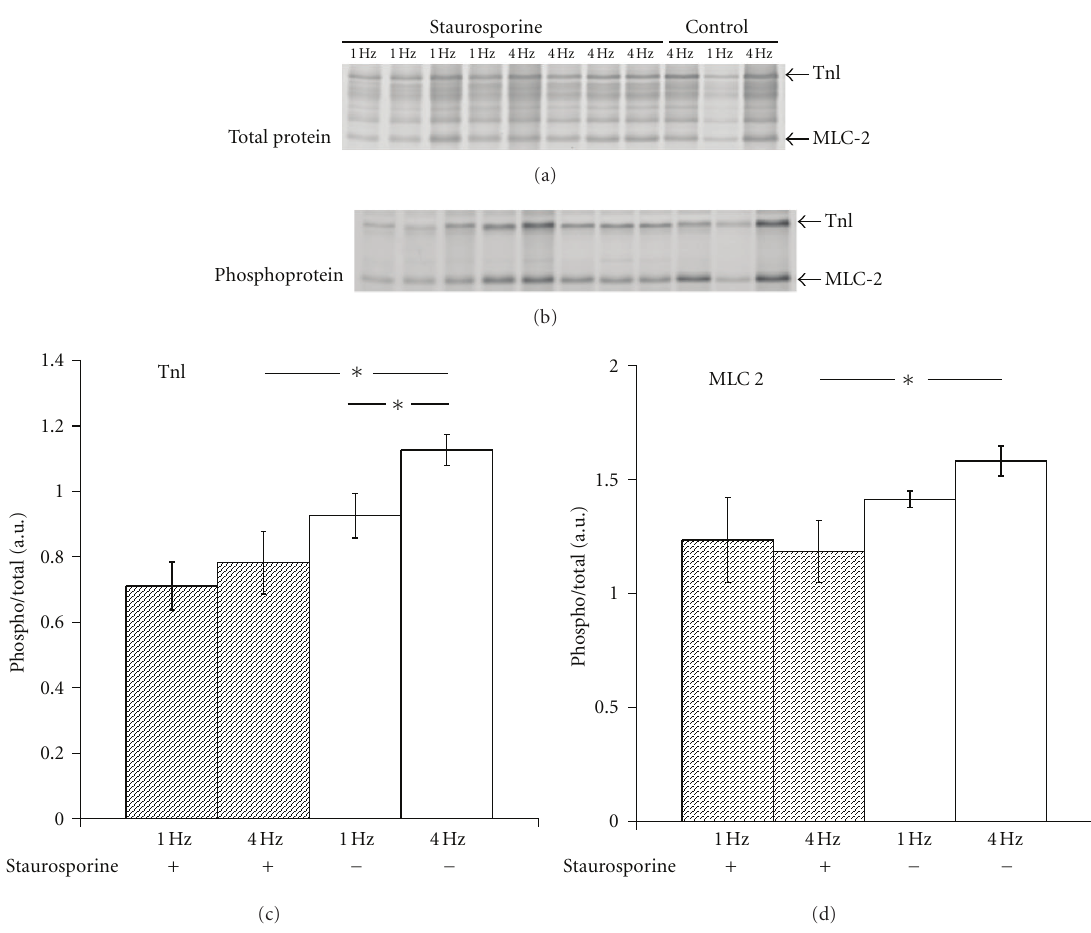
Figure 5: Analysis of TnI and MLC-2 phosphorylation status in muscles stimulated to twitch at 1 or 4Hz, with and without staurosporine. Panel (a) shows a representative SDS gel stained for total protein using the Sypro Ruby protein stain. Panel (b) shows the same gel counterstained for phosphoprotein using the Pro-Q Diamond Stain. Densitometric analysis of bands corresponding to TnI and MLC-2 was obtained from each stain and the ratio of phosphoprotein to total protein calculated for each group. TnI phospho/total protein ratio is shown in panel (c) and MLC-2 shown in panel (d) ( n = 4 for each group, other gel not shown); error bars are SEM, ∗ P < 0 . 05 considered